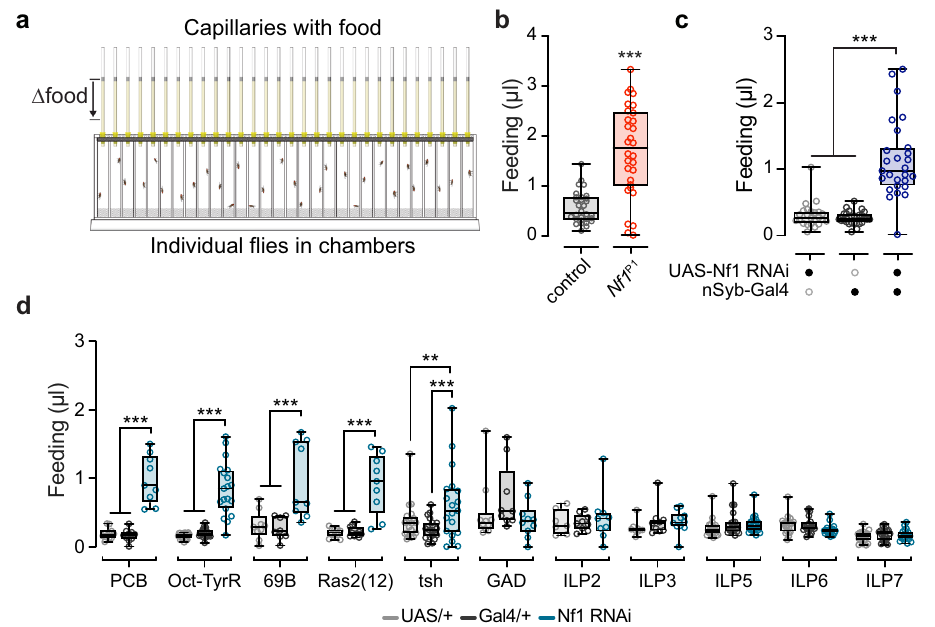
Fig. 6 Loss of Nf1 increases feeding. a Illustration of the capillary feeding apparatus. b Feeding in Nf1 P1 mutants and w CS10 controls. *** p < 0.001 (Mann – Whitney, two-sided; n = 30 per genotype). c Feeding with pan-neuronal Nf1 RNAi (driven by nSyb-Gal4) and heterozygous Gal4/ + and UAS/ + controls. *** p < 0.001 (Dunn ’ s test, two-sided; n = 20 per genotype). d Feeding measured with knockdown of Nf1 in different subsets of neurons with various Gal4 drivers. * p < 0.05, ** p < 0.01, *** p < 0.001 (Sidak, two-sided; n = 7 – 20). Exact sample sizes and p -values found in Source data fi le for ( d ). Each “ n ” represents a single fl y in a chamber. Box plots — box: 1st to 3rd quartiles, median: line, whiskers: min – max, individual data points: